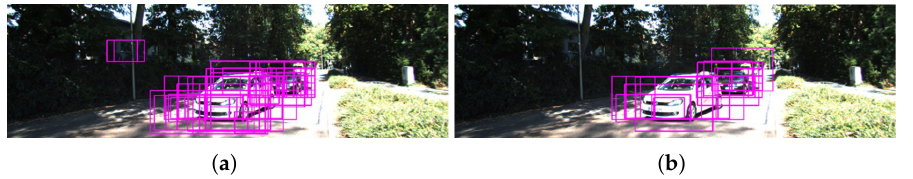
Figure 2. Initial detections of our approach with cascade vs. without cascade. ( a ) Initial detections without cascade; ( b ) Initial detections with